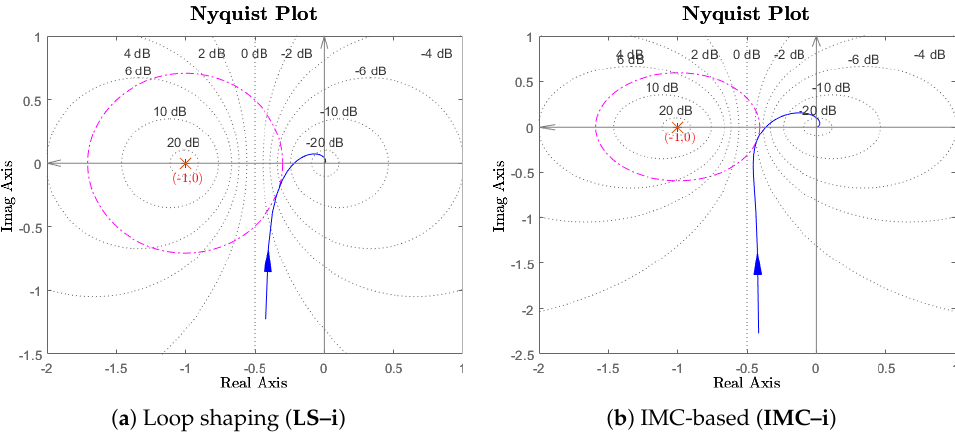
Figure 17. Nyquist plots for pitch angle control loop